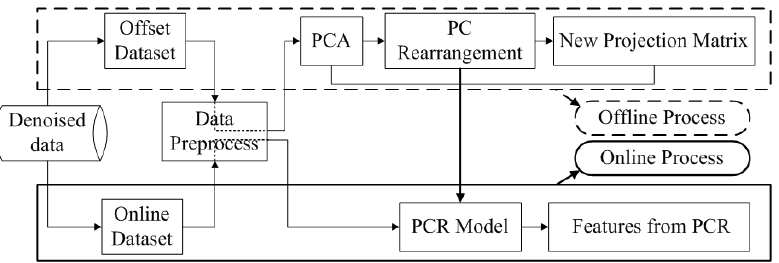
Figure 7. Framework of the using process based on Principal Components Rearrangement